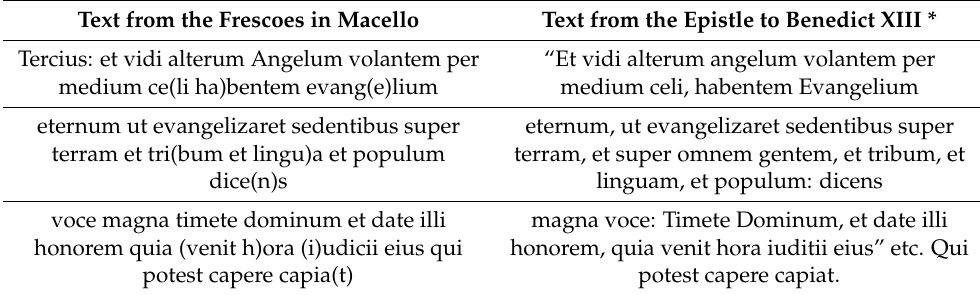
Table 4. Textual comparison, banderole 4 in the vision of beatus Vincentius. Text from the Frescoes in Macello Text from the Epistle to Benedict XIII